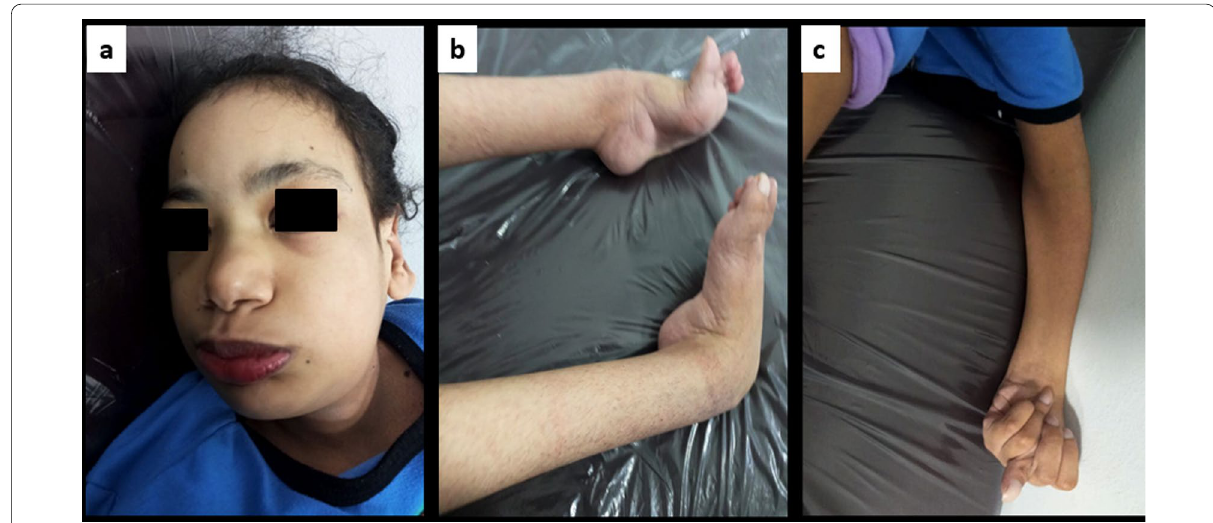
Fig. 2 18‑years‑old female patient, a The patient’s coarse facies with right plagiocephaly, small cupped low set ear, depressed nasal bridge, triangular face, upward slanting, epicanthus fold, squint and broad eye gaps. b Extensive contracture at ankle, secondary to the severe lower limb spasticity. c Overlapped fingers due to marked Spasticity of the left hand